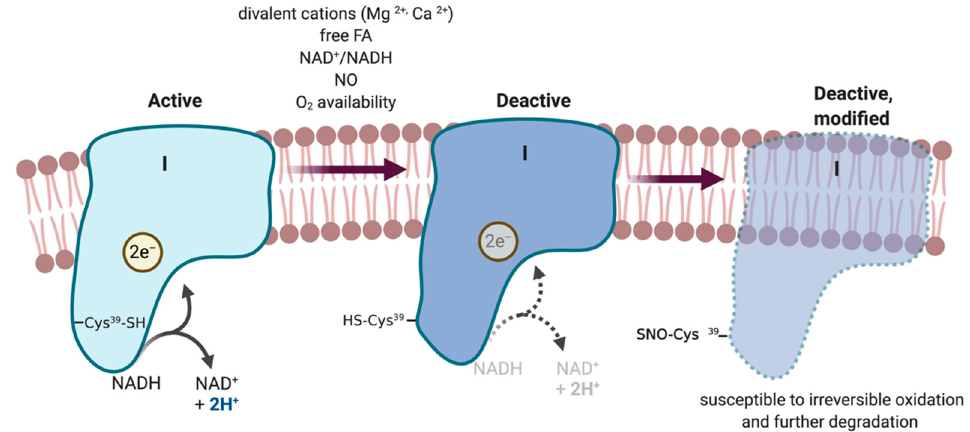
Figure 3. A/D transition of mitochondrial Complex I. The A-form of CI is capable of catalysis, but D-form is not. Divalent cations and free fatty acids influence the dynamics of the A/D transition. Majorly, substrate availability depicted by NAD + /NADH ratio in the matrix, together with presence of NO or hypoxic conditions strongly favor the kinetic of the A/D transition. Exposure of Cys 39 of ND3 subunit of CI makes the D-form susceptible for thiol modifications that define deactivation reversibility, with nitrosation being the lead for further oxidation and potentially irreversible modifications and destruction of the enzyme.